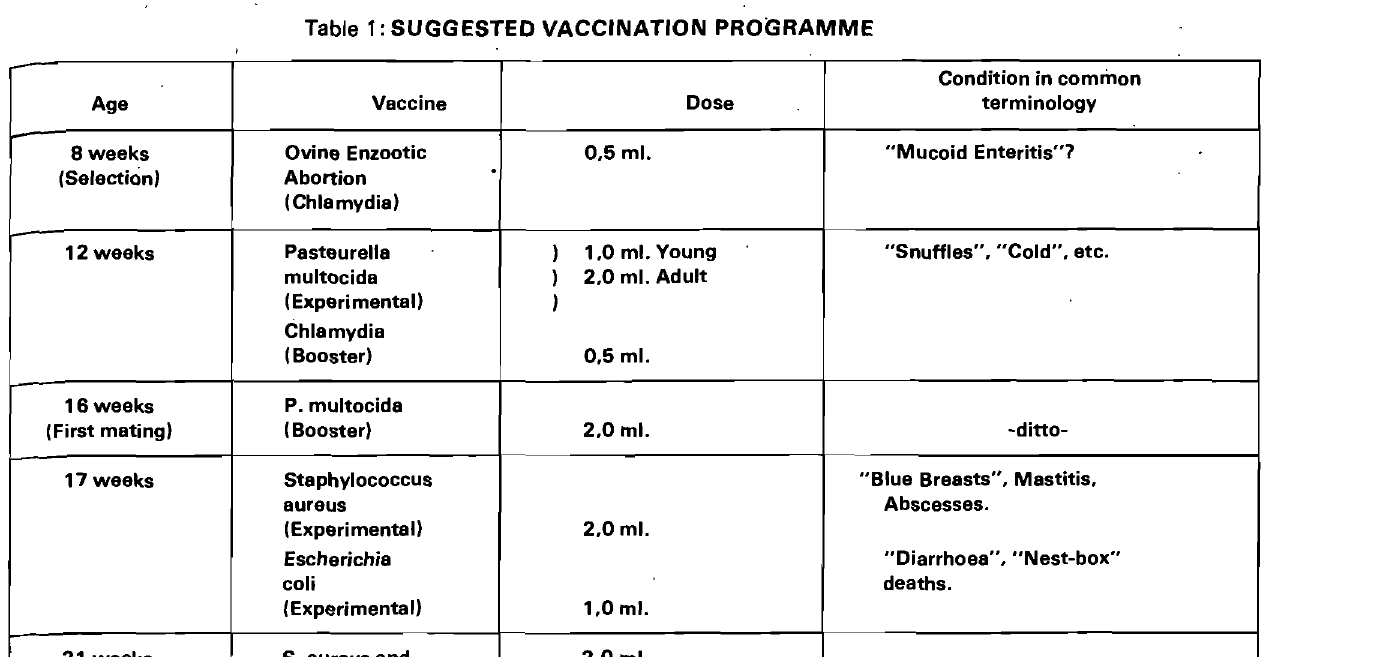
Table 2: MANAGEMENT STANDARDS